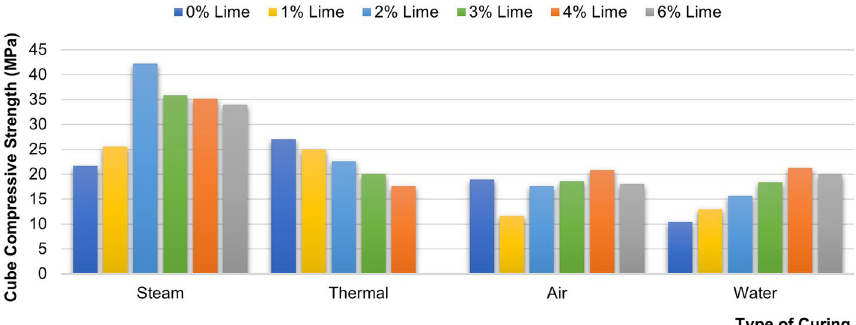
Fig. 4 The effect of curing type on the 28-day concrete compressive strength for different lime contents and for constant NaOH molarity of